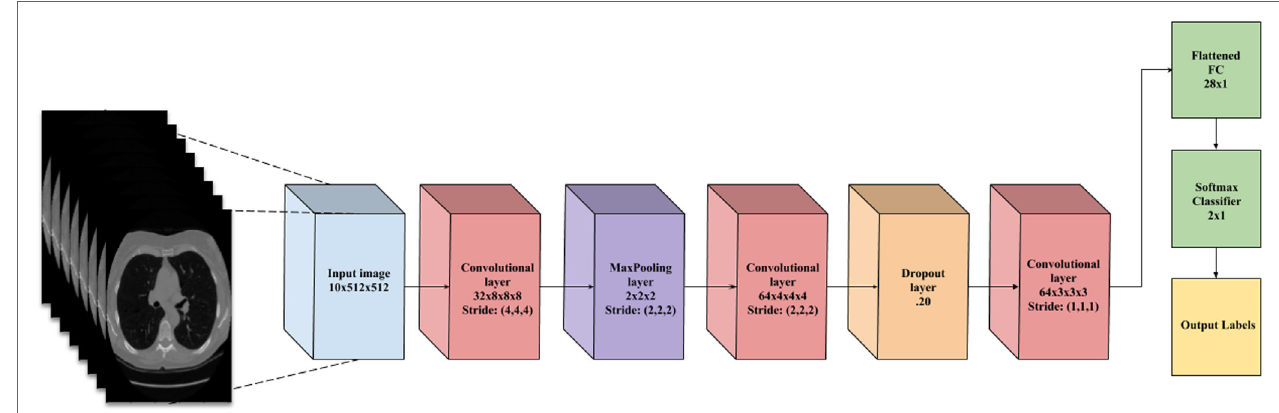
FigUre 3 | A flowchart of the convolutional neural network architecture. Blue box is the input image. Red boxes are convolutional layers with rectified linear unit activation. Purple box is the max pooling layer. Cyan box is the dropout layer. Green box is the fully connected layer and softmax binary classifier. Yellow is the output of the